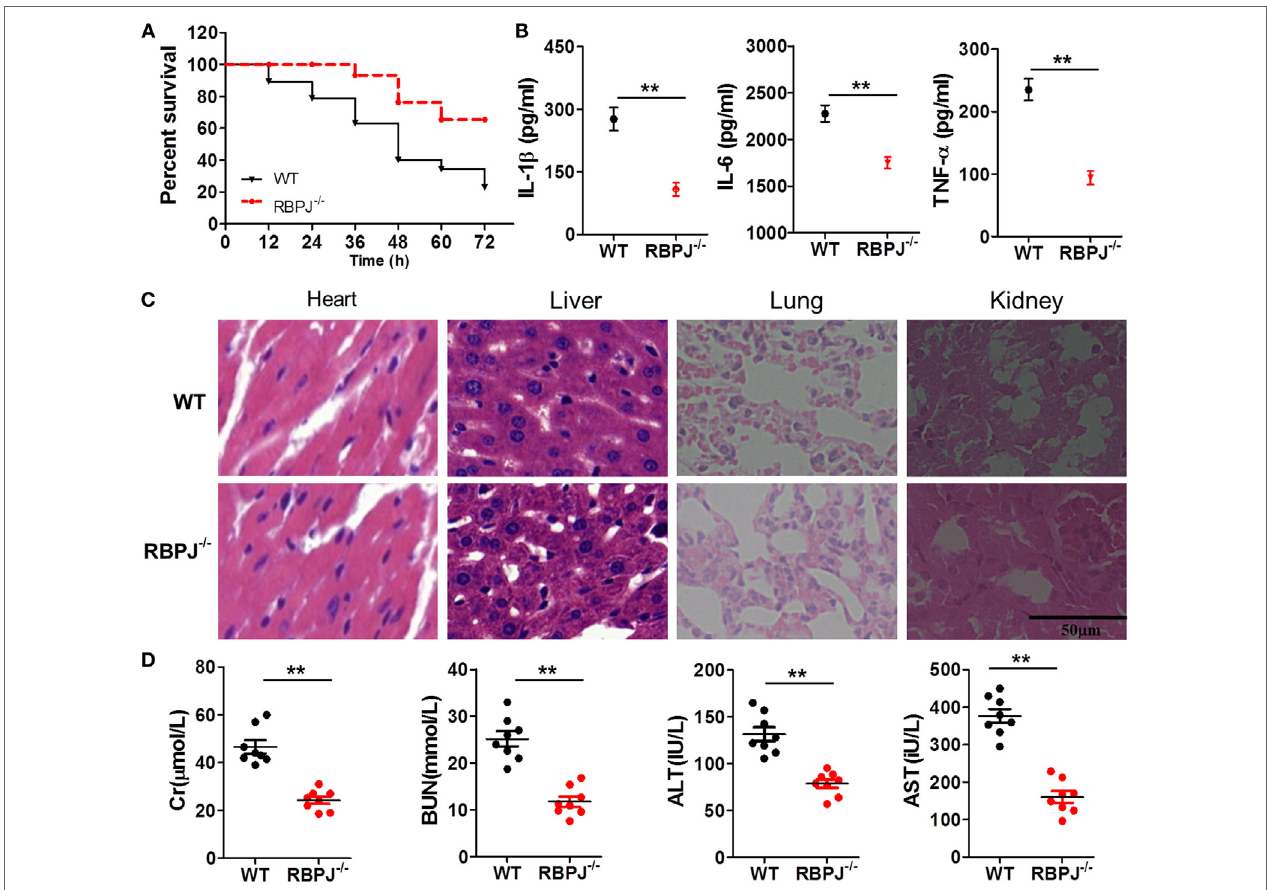
FigUre 8 | RBP-J knockout resulted in decreased inflammation in vivo . (a) Survival rates of wild-type (WT) and RBP-J − / − mice after 72-h stimulation with lipopolysaccharide (LPS). (b) IL-1 β , IL-6, and TNF- α levels in blood were measured using a microplate reader. (c) Hematoxylin and eosin staining of heart, liver, lung, and kidney tissues from RBP-J − / − and WT mice after peritoneal injection of LPS. Sections were examined and photographed under a microscope. (D) Levels of creatinine (Cr), blood urea nitrogen (BUN), alanine aminotransferase (ALT), and aspartate transaminase (AST) in blood were determined using commercial ELISA kits. ** p < 0.01 compared with WT mice; n = 6. Scale bar = 50